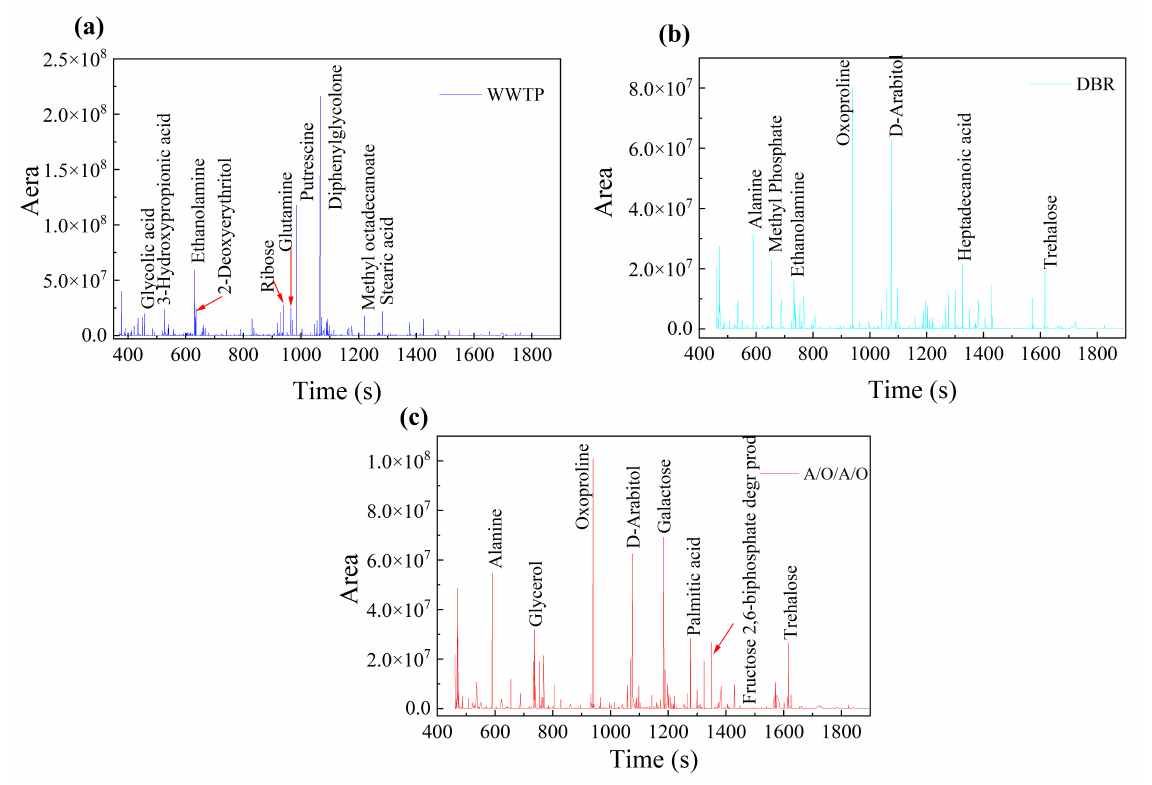
Figure 7. Metabolite analysis in WWTP ( a ); DBR ( b ); and A/O/A/O ( c )